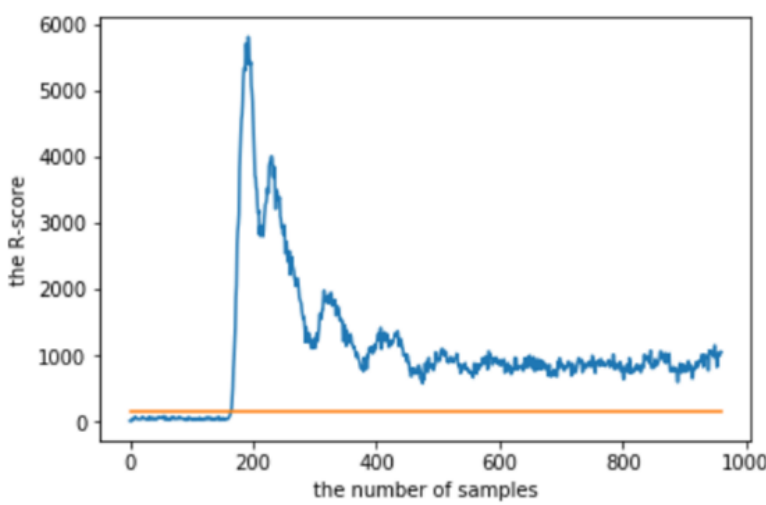
Figure 8. The R-score of the 1DAAE for fault 1.